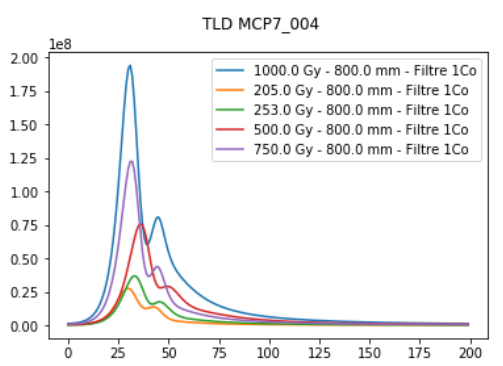
Fig. 4. Luminescence curves at different doses for a MCP7 after irradiations carried out for the calibration phase. (“ Filtre 1Co ”: measurement with